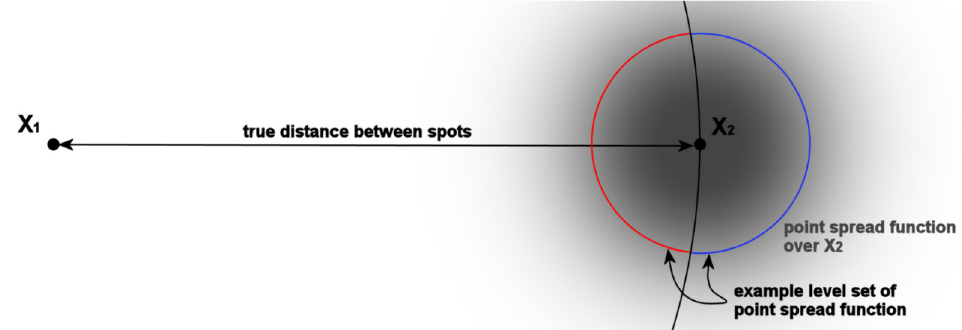
Fig 1. Schematic of the inflation of distances with diffraction limited spot measurements. The blue and red arcs together form a level set of the point spread function of spot 2 at true position X 2 (grey). Thus the measured position of spot 2 is equally likely on any position on these arcs. The blue arc being longer than the red arc implies that spot 2 is more likely to be measured further away from spot 1 than their true distance. On average the measured distance is thus larger than the true